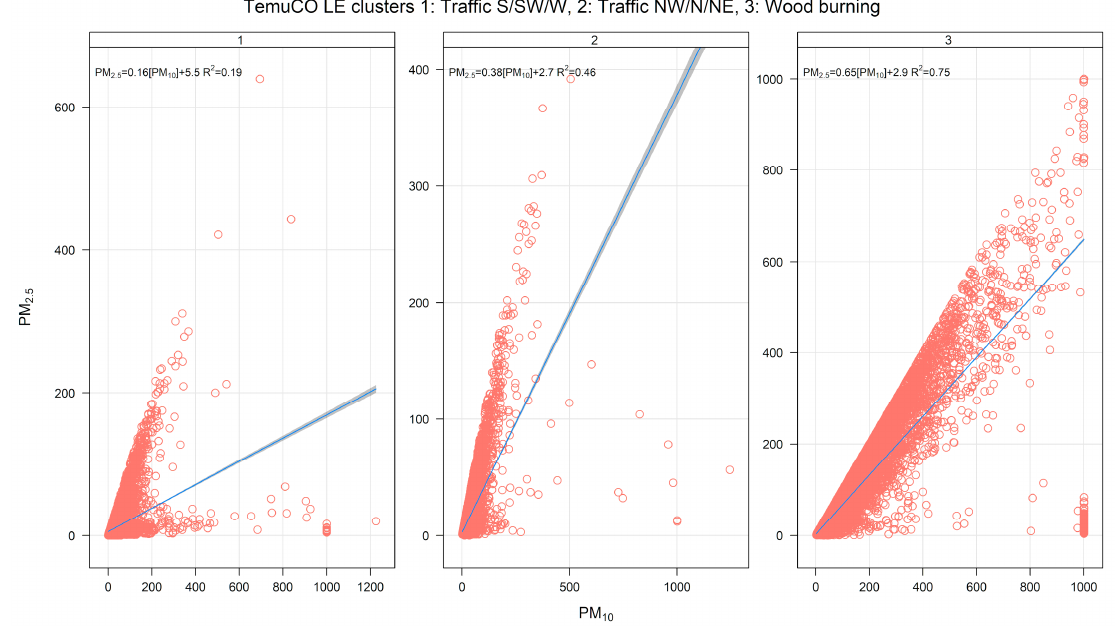
Figure 10. PM 2.5 –PM 10 scatter plot by cluster, for a three-cluster solution for Temuco.